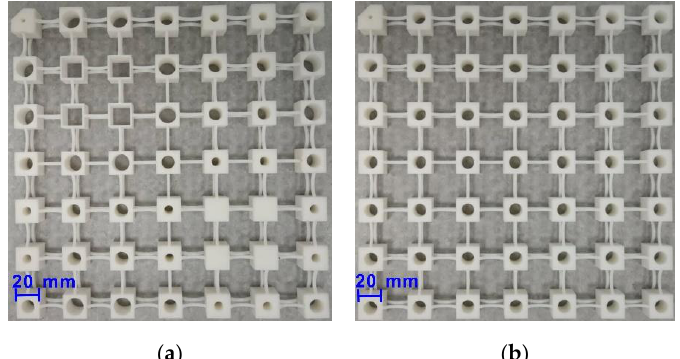
Figure 5. Photographs of the manufactured ( a ) rainbow metamaterial and ( b ) periodic metamaterial using selective laser sintering (SLS).